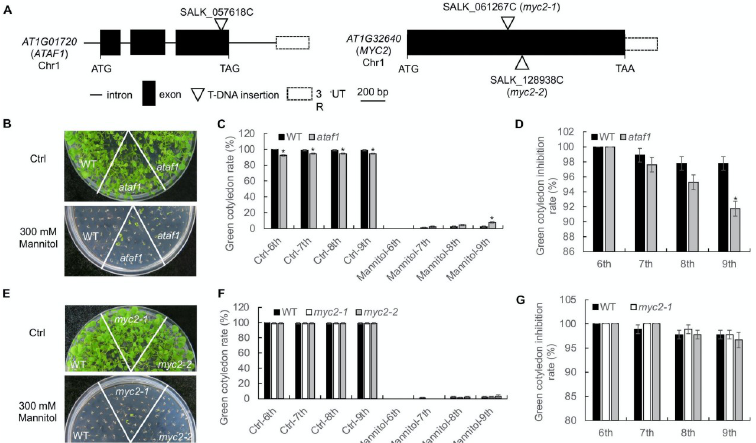
Fig 8. Results from validation experiments. A . The scheme of the ATAF1 and MYC2 genomic DNA and T-DNA insertion. The panel is a schematic illustration of the ATAF1 and MYC2 genomic DNA with exons (solid box), intron (lines) and 3’ untranslated region (open box). The position of T-DNA insertion of ataf1 (SALK_057618C), myc2 (SALK_061267C, SALK_128938C)was labeled. B . The ataf1 mutant is more resistant to mannitol treatment. Wild-type (WT) Col-0 and ataf1 mutant seeds were germinated on 1/2 MS medium with or without 300 mM mannitol. 30 seeds per genotype were used for each replicate. The photos were taken four-week post-germination. C . Quantification of cotyledon greening on plates corresponding to B. Seedlings with green cotyledon expansion were counted at 6–9 days post-germination. Data are shown as means ± SD (standard deviation) from three independent replicates (n = 3, � , p < 0.05, Student’s t-test). D . Quantification of cotyledon greening inhibition rate on plates corresponding to B. Seedlings with green cotyledon expansion were counted at 6–9 days post-germination. Data are shown as means ± SD from three independent replicates (n = 3, � , p < 0.05, Student’s t-test). E . Growth of WT and myc2 mutants on MS plates. WT and myc2 mutant seeds were germinated on 1/2 MS medium with or without 300 mM mannitol. 30 seeds per genotype were used for each replicate. The photos were taken four-week post-germination. F . Quantification of cotyledon greening on plates corresponding to E. Seedlings with green cotyledon expansion were counted at 6–9 days post-germination. Data are shown as means ± SD from three independent replicates (n = 3, no statistical significance with Student’s t-test). G . Quantification of cotyledon greening on plates corresponding to E. Seedlings with green cotyledon expansion were counted at 6–9 days post-germination. Data are shown as means ± SD from three independent replicates (n = 3, no statistical significance with Student’s t-test).